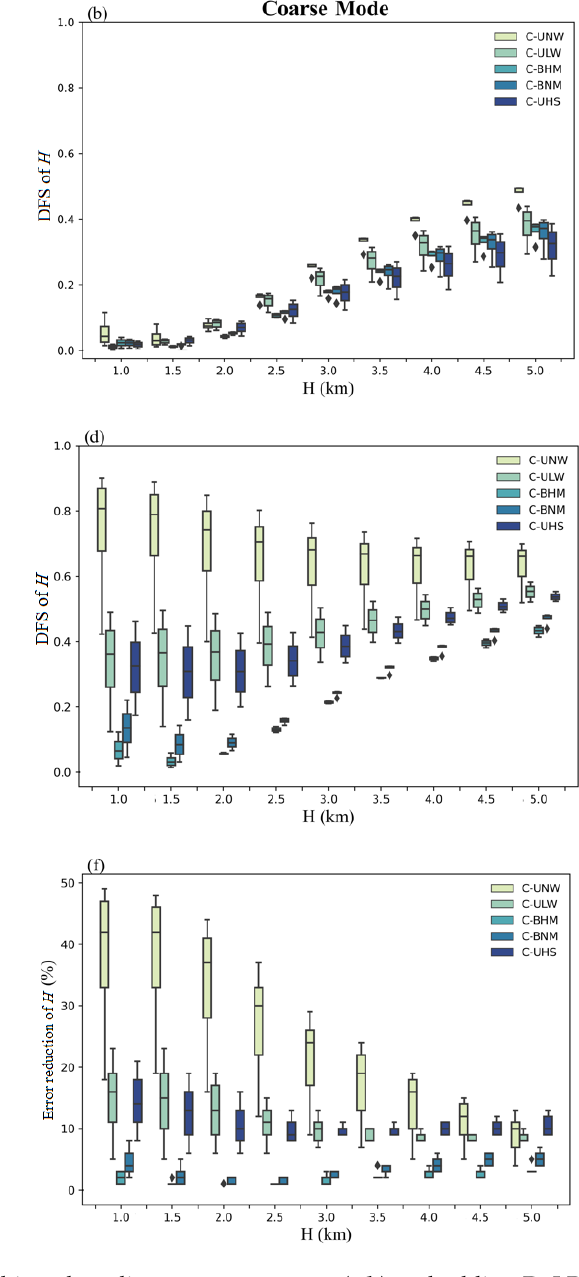
Figure 7. The DFS of H from multi-angle radiance measurements ( a , b ) and adding DoLP measurements ( c , d ), as well as the posterior error uncertainty reduction between these two types measurements ( e , f ) under different aerosol conditions for ten aerosol models over vegetation surface. ( a , c , e ) represent fine mode aerosol types and ( b , d , f ) represent coarse mode aerosol types.